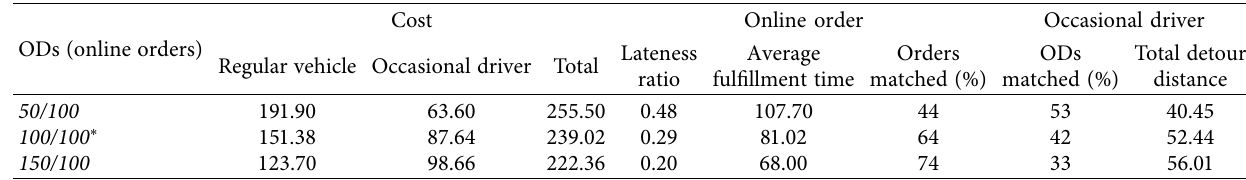
Table 6: Impacts of the ratio of ODs to online orders.